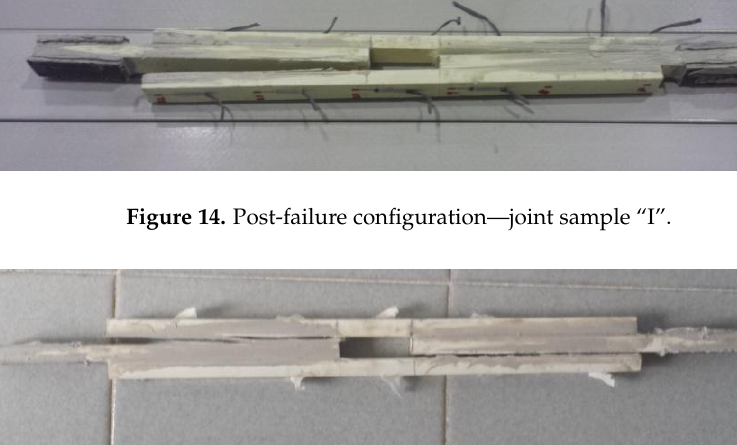
Figure 15. Post-failure configuration—joint sample “II”.